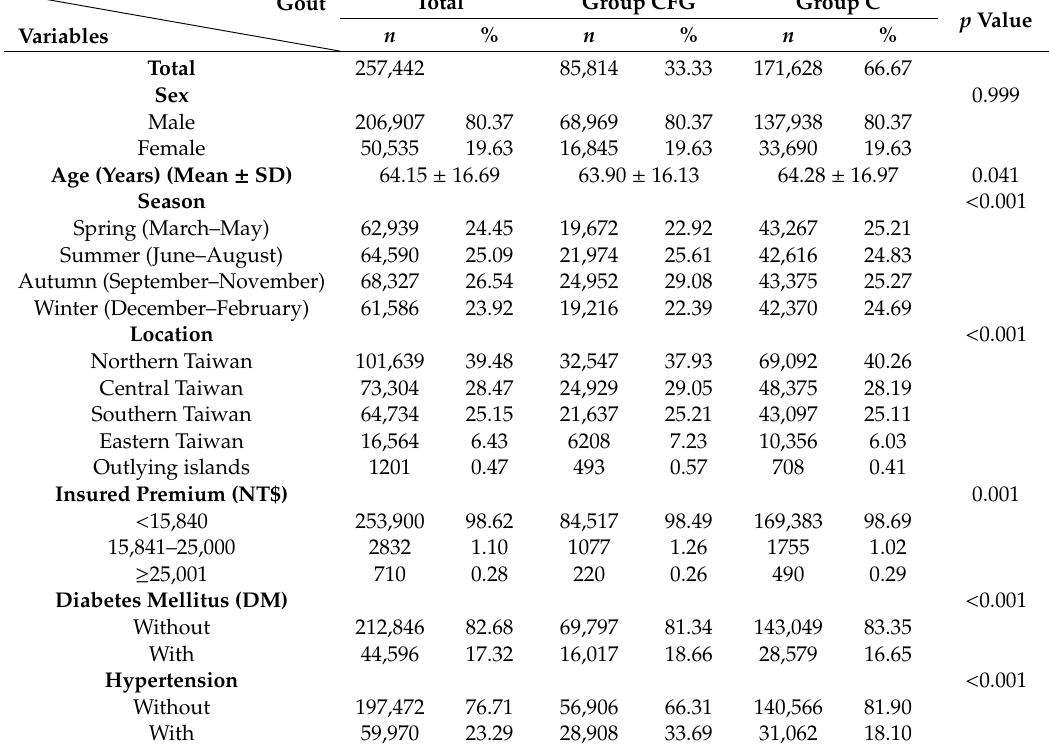
Table 1. Demographic and Comorbidities of Patients with Gout (Group CFG) and Without (Group